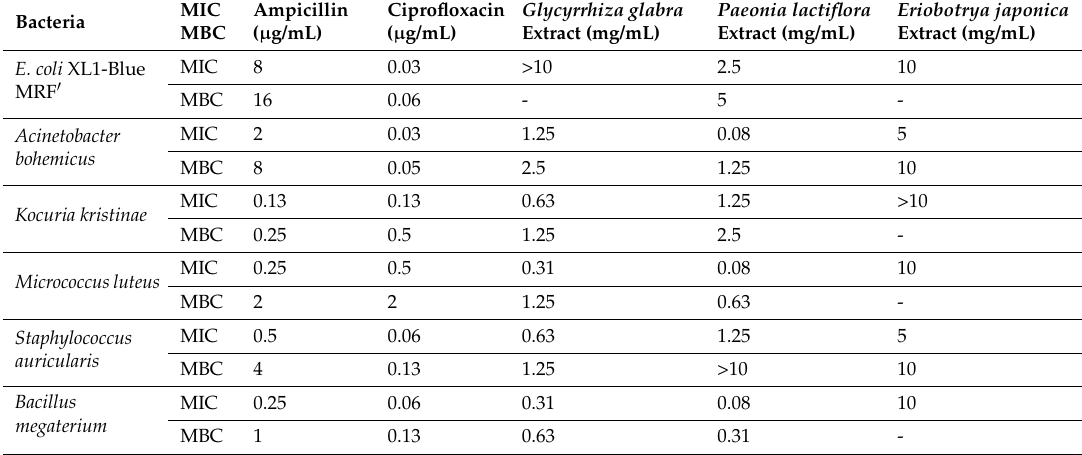
Table 5. Minimum inhibitory concentration (MIC) and minimum bactericidal concentration (MBC) of the three plant